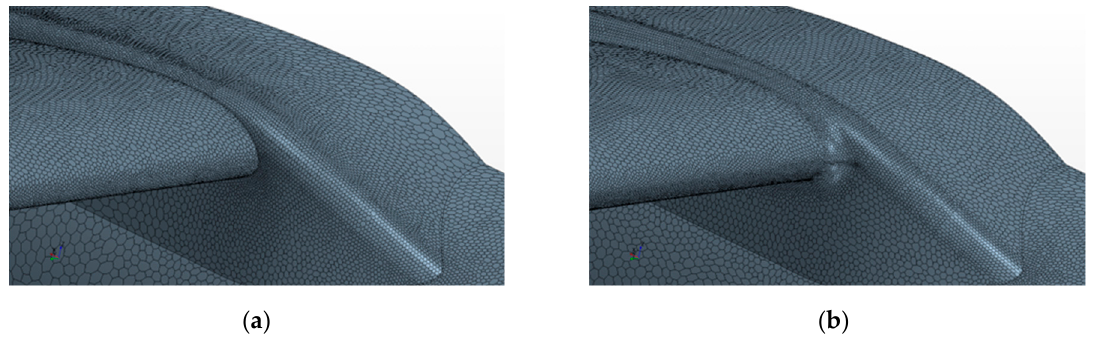
Figure 16. Wing–fuselage fairing geometries without ( a ) and with ( b ) fillet.